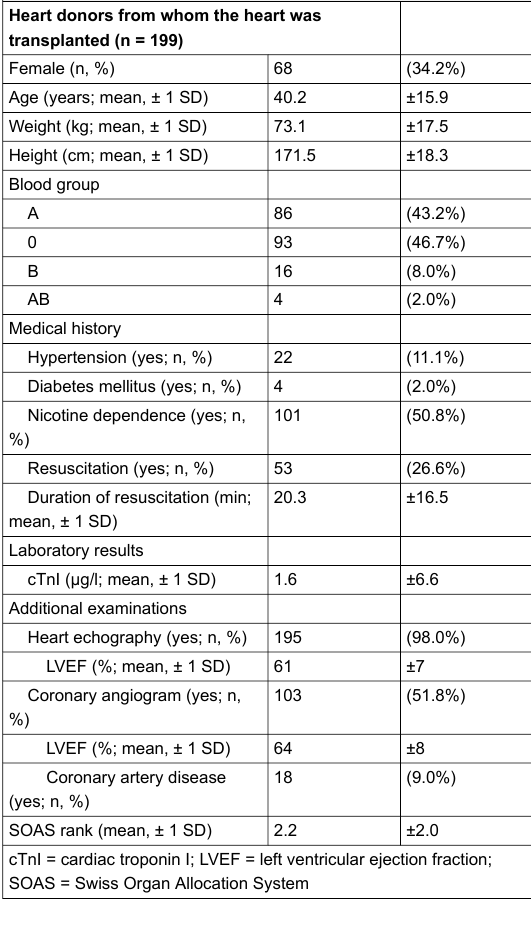
Table 2: Patient characteristics and clinical data of donors.